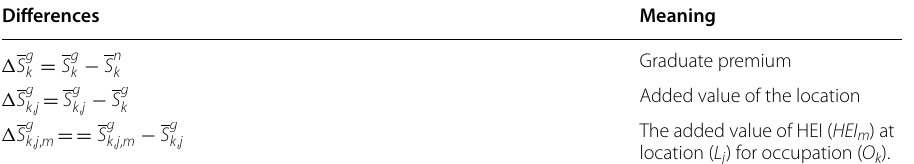
Table 2 Income differences and their meaning Differences